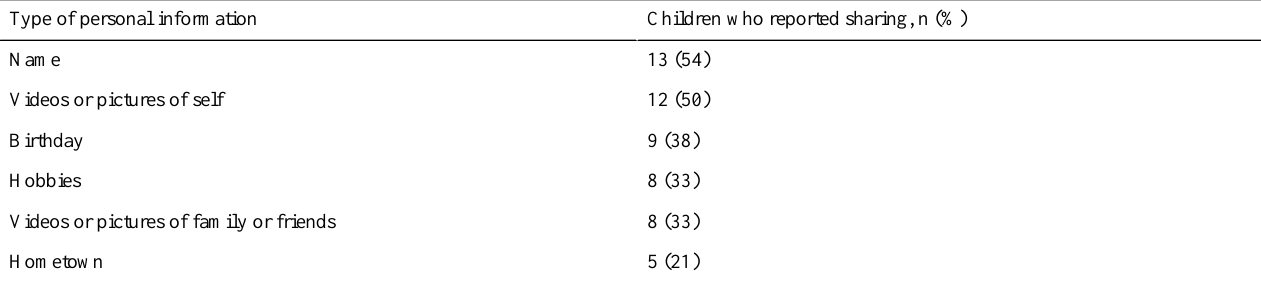
Table 2. Personal information shared by children through social media (n=24).